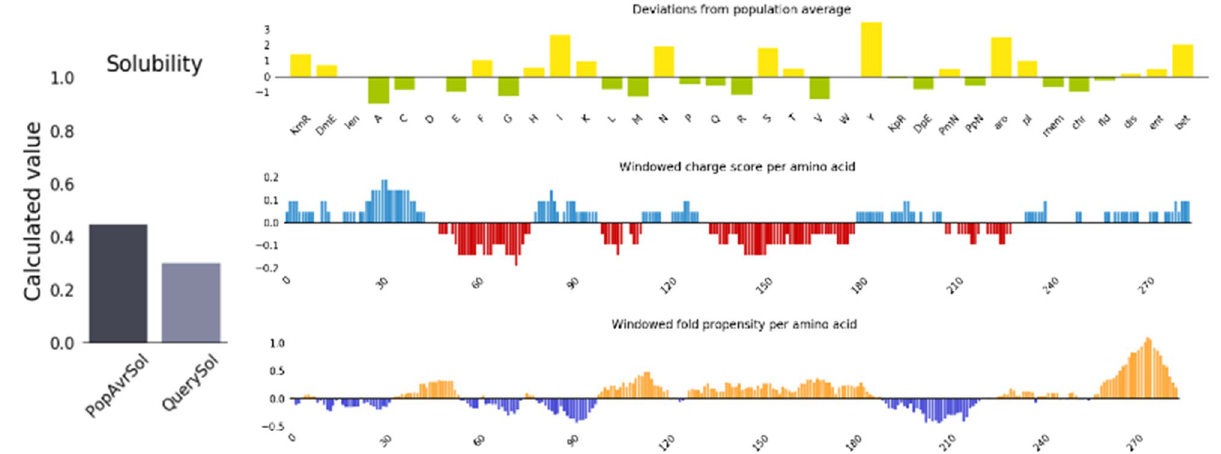
Figure 12. Solubility prediction of designed vaccine by protein-SOL